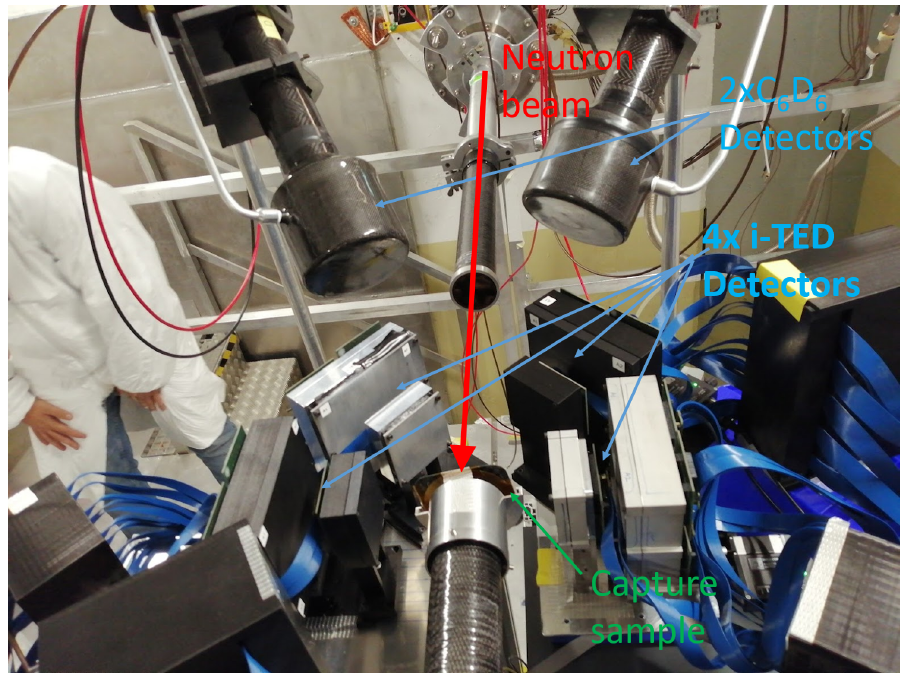
Figure 7. Photograph of the experimental setup at CERN’s n_TOF EAR1, for detector commissioning measurements in 2021. The sample is surrounded by two state-of-the-art C-fibre C 6 D 6 detectors and four i-TED Compton modules developed in the HYMNS ERC project